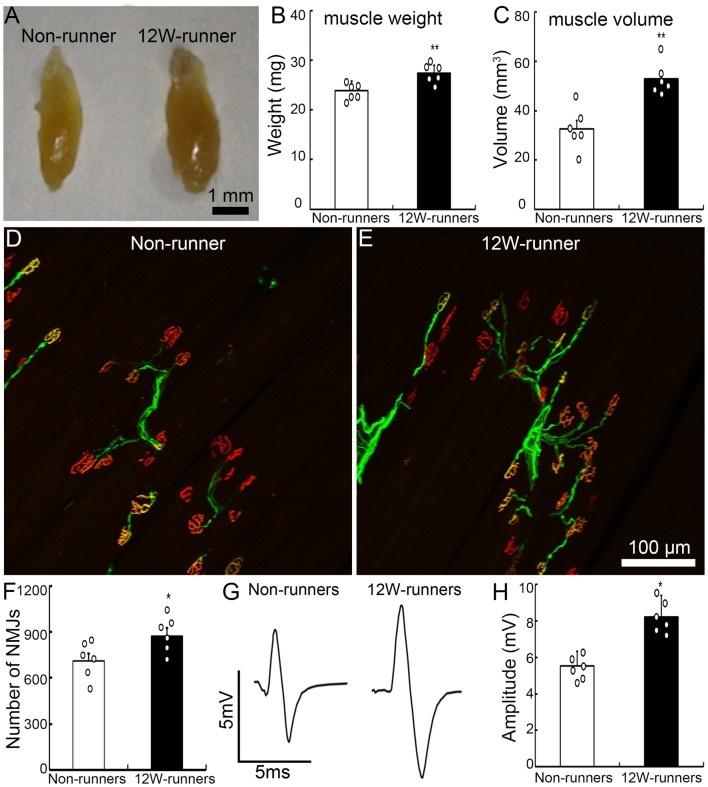
Exercise fosters reorganization of neuromuscular junctions. (A–C) Twelve-week (12W) exercise increases the wet weight and volume of biceps in mutant mice. Each circle represents the data from one animal. **P < 0.01; n = 6. (D–F) Examples of neuromuscular junctions in a non-runner (D) and a runner after 12-week exercise (E), illustrating the higher number of nerve terminals (neurofilaments, green) and acetylcholine receptor clusters (α-BT, red) in runners, quantified in (F). Each circle represents the data from one animal. *P < 0.05; n = 6. (G,H) Electromyographic comparison. The peak-to-peak electromyography amplitude is increased in runners (G, right) vs. non-runners (G, left), as quantified in (H). Each circle represents the data from one animal. *P < 0.05; n = 6.